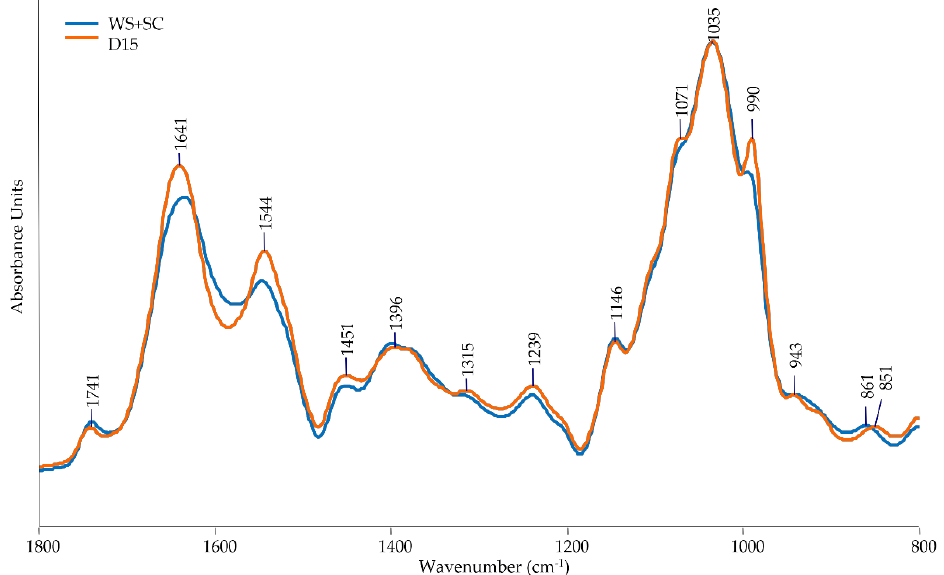
Figure 7. ATR-FTIR spectra (1800–800 cm − 1 ) of the fruiting bodies of P. ostreatus harvested from the two growing substrates WS + SC (blue line) and D15 (orange line). two growing substrates WS + SC (blue line) and D15 (orange